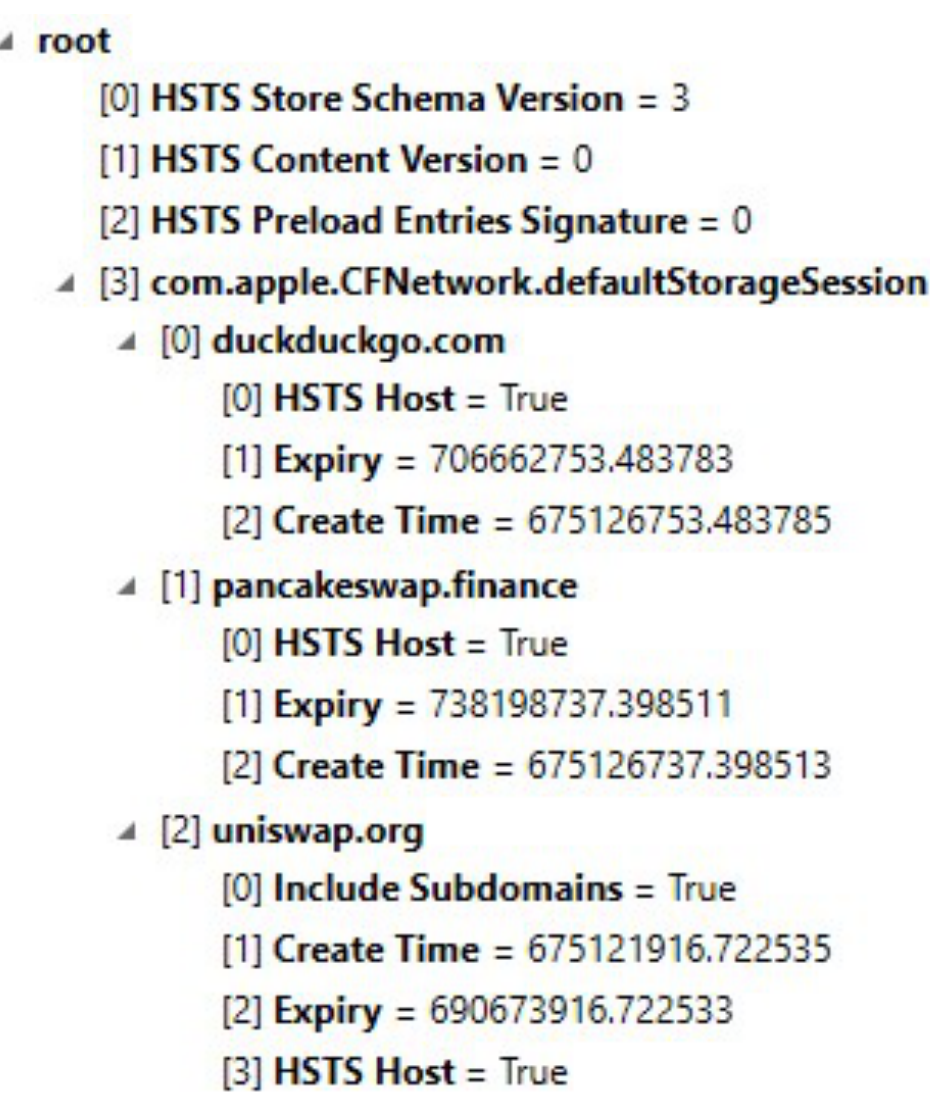
Figure 15. Example of the HSTS.plist file content.